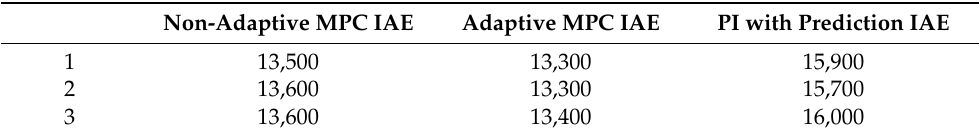
Table 7. The effect of disturbances in the feed and reaction kinetics on the IAE. (1) Setpoint 15 mM without disturbance (for reference); (2) a 20% increase in the glucose feed concentration between 100 and 150 h; (3) a 50% increase in the lag constant